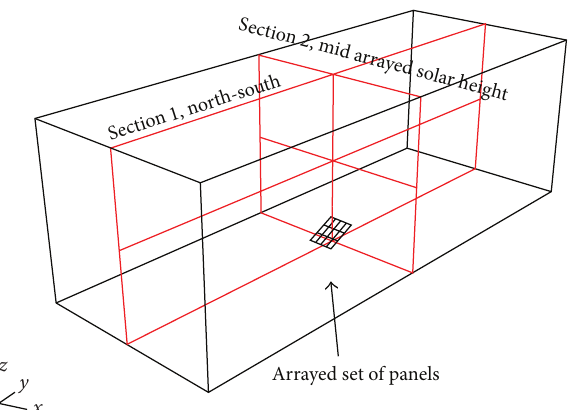
Figure 12: Schematic diagram showing two arrayed set solar panel cross sections used for results presentation.